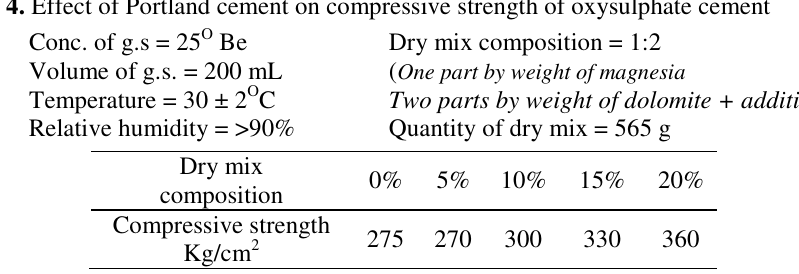
Table 4. Effect of Portland cement on compressive strength of oxysulphate cement Conc. of g.s = 25 O